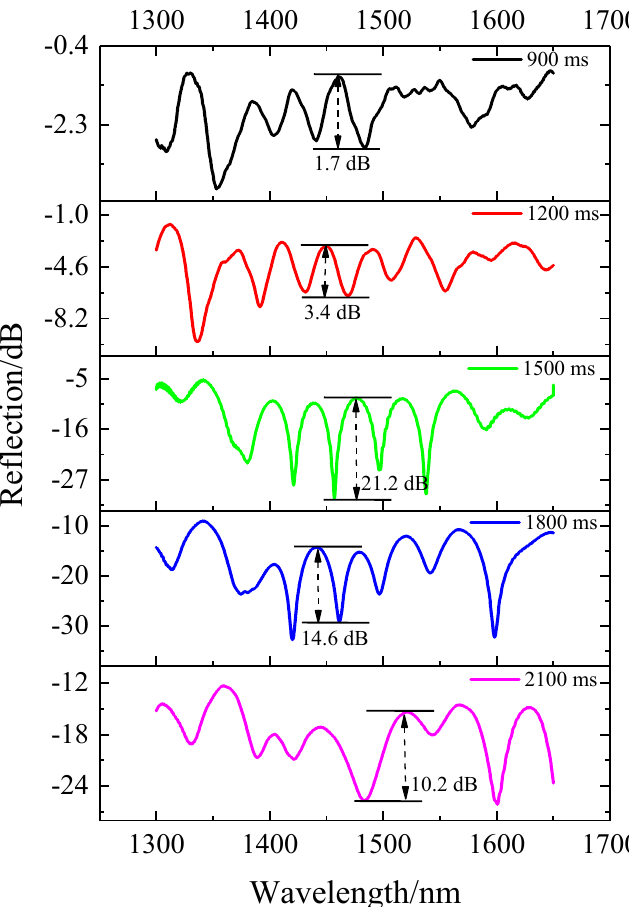
Figure 5. Reflection spectra of the MI structure under different discharge times with L = 6 mm.